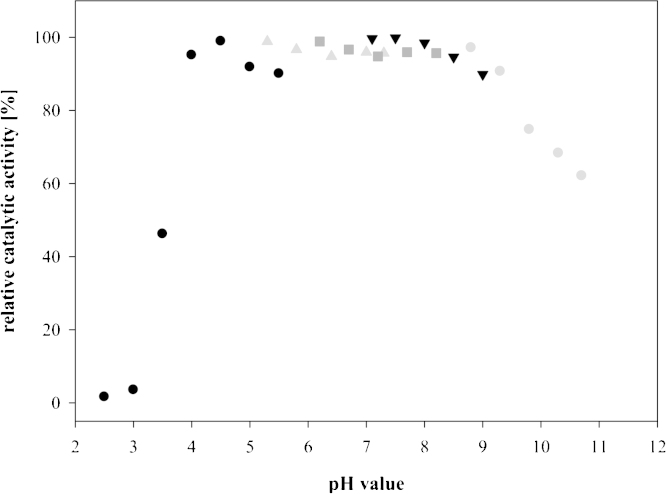
pH stability of HRP. ●, citrate-buffer; ▴, carbonate-buffer; ■, phosphate-buffer; ▾, TRIS-buffer; ●, glycine-buffer.